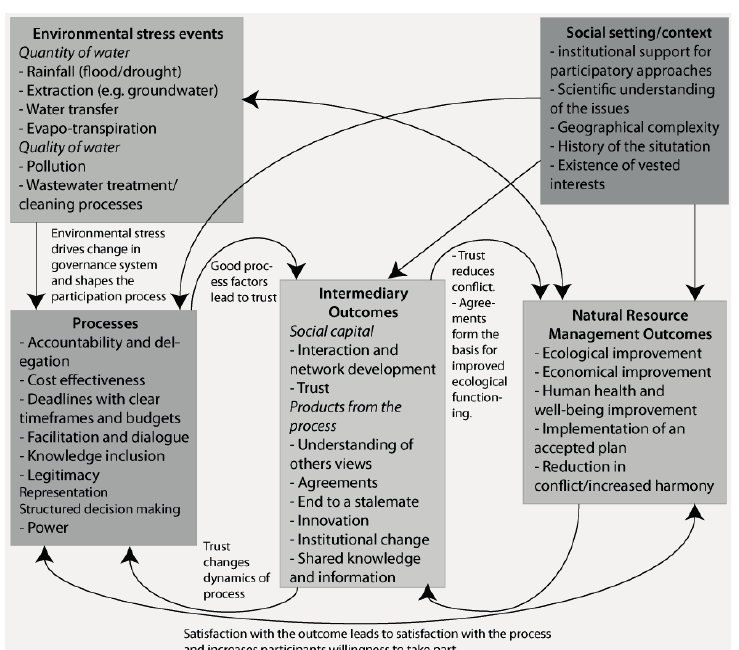
Fig. 1 Framework for evaluating the drivers of stakeholder participation, its processes and its